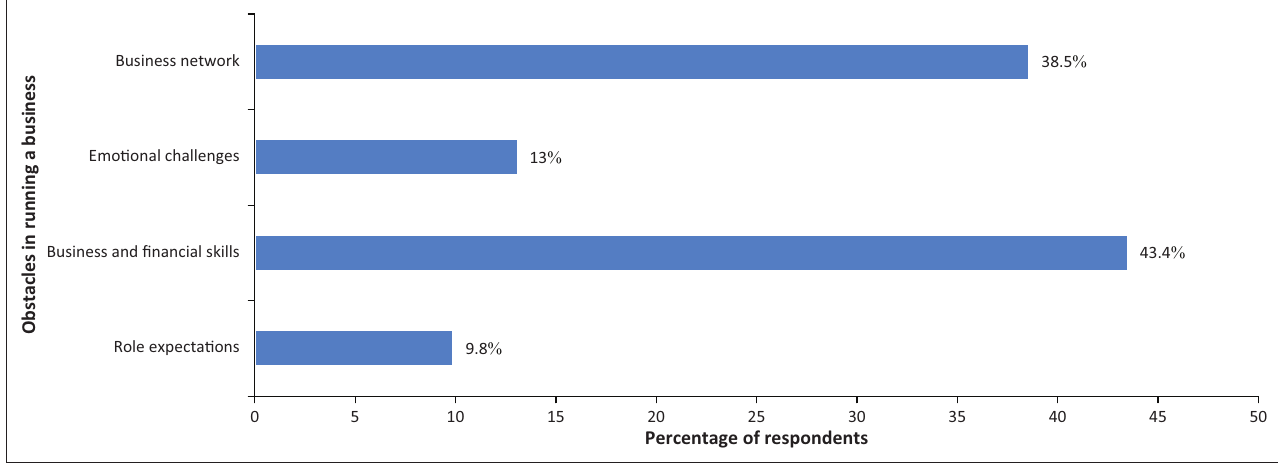
FIGURE 2: What are the main obstacles for running your